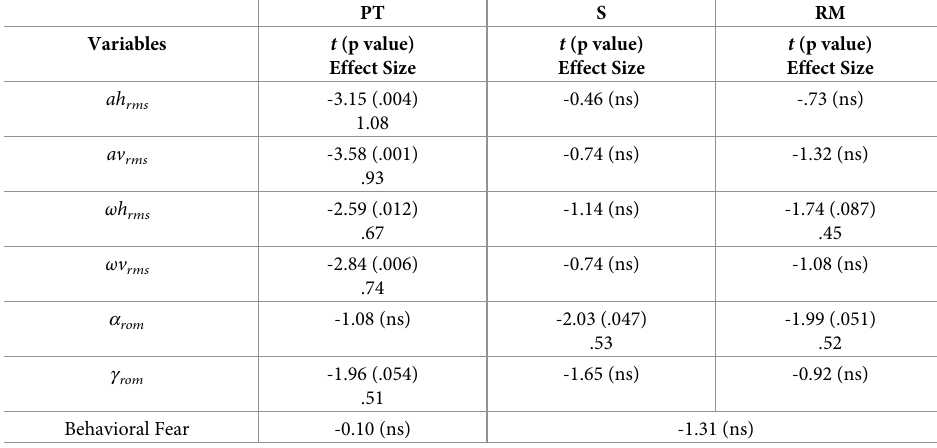
Behavioral Fear -0.10 (ns) -1.31 (ns) T-statistics (t), p values and effect sizes (when significant) for each IMU-derived movement variable during the Potential Threat (PT), Startle (S), and Response Modulation (RM) phases, and behavioral fear codes during the Potential Threat and Acute Threat phases between children with (n = 21) and without (n = 40) internalizing diagnosis. (cid:3) ns indicates p values >